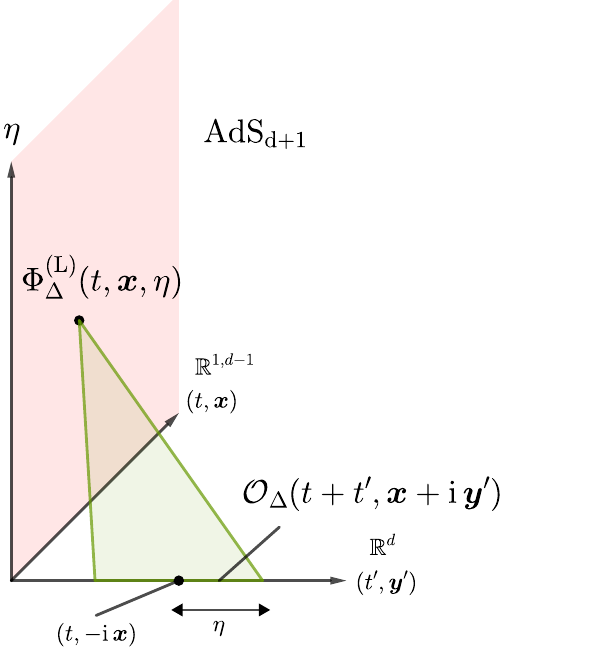
Figure 3 . The HKLL representation of the AdS scalar (cid:12)eld. The bulk (cid:12)eld (cid:8) (L) space-time is constructed by smearing a scalar primary O (cid:1) on a region in Euclidean space with the HKLL